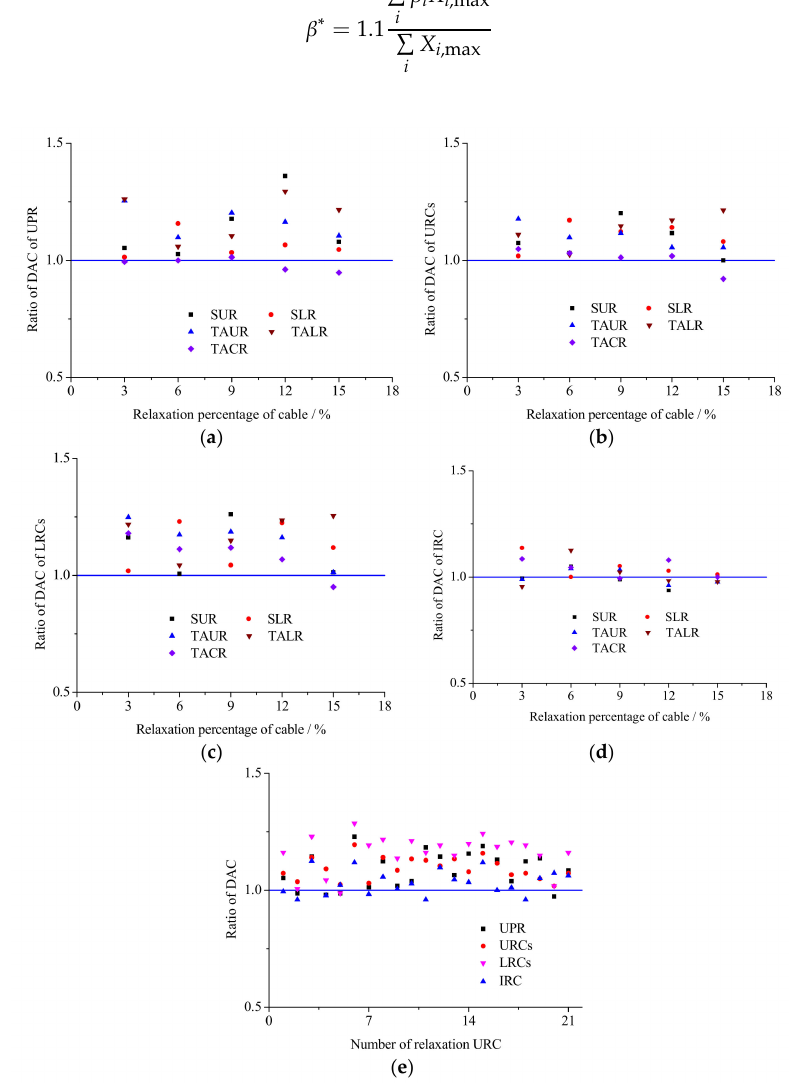
Figure 12. Ratio of displacement amplification coe ffi cient (DAC). ( a ) UPR; ( b ) URCs; ( c ) LRCs; ( d ) IRC; ( e ) Relaxation